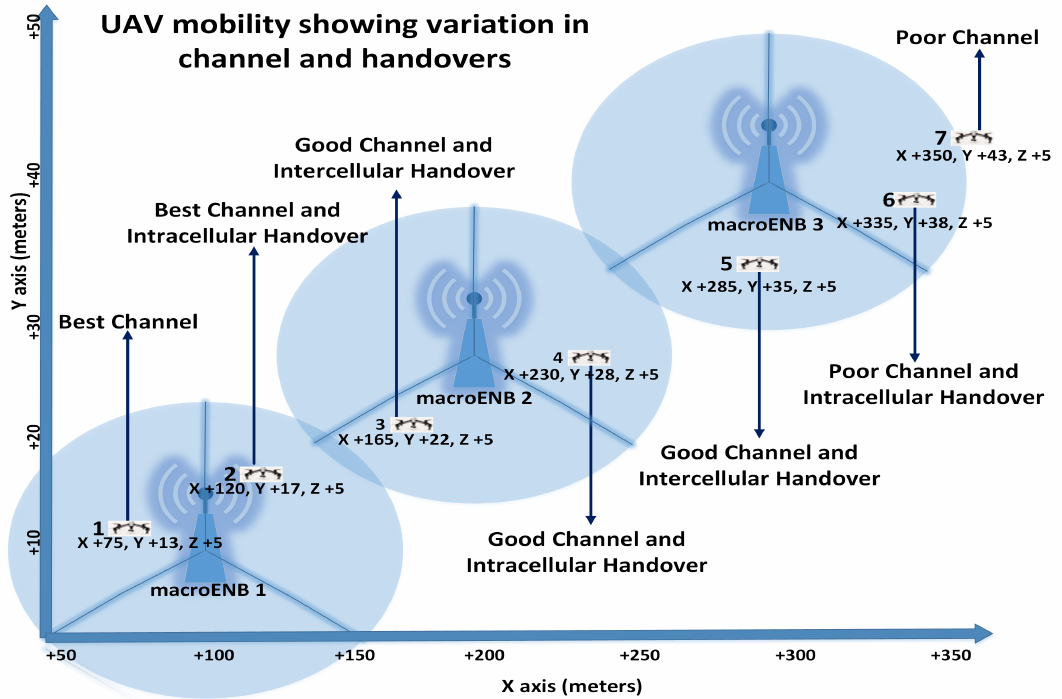
Figure 5. Coordinates indicating waypoints on the fixed flight